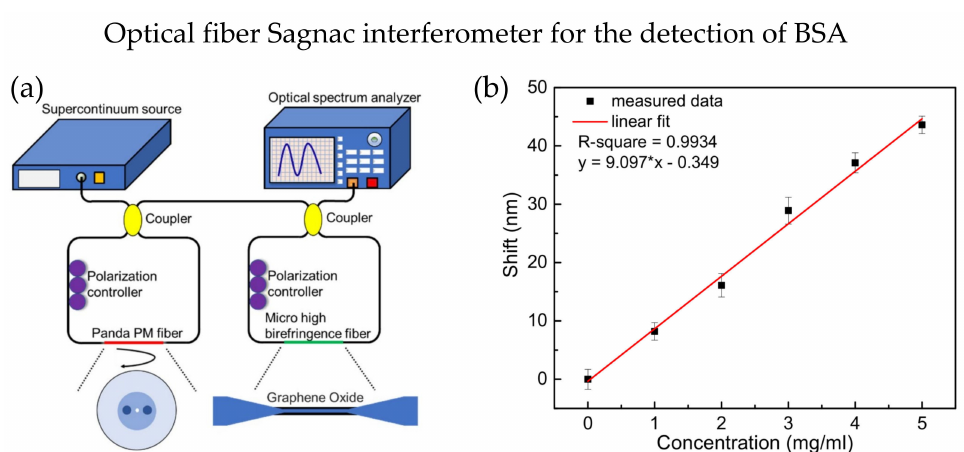
Figure 8. ( a ) Experimental setup of cascaded SI sensor, the micro high birefringence fiber has a diameter of 6 µ m and coated with graphene oxide. ( b ) The wavelength shift of the cascaded SI sensor with difference concentrations of BSA is linear with sensitivity around 9.097 nm/(mg × mL − 1 ). Adapted with permission from Ref. [88]. Copyright 2018, MDPI.